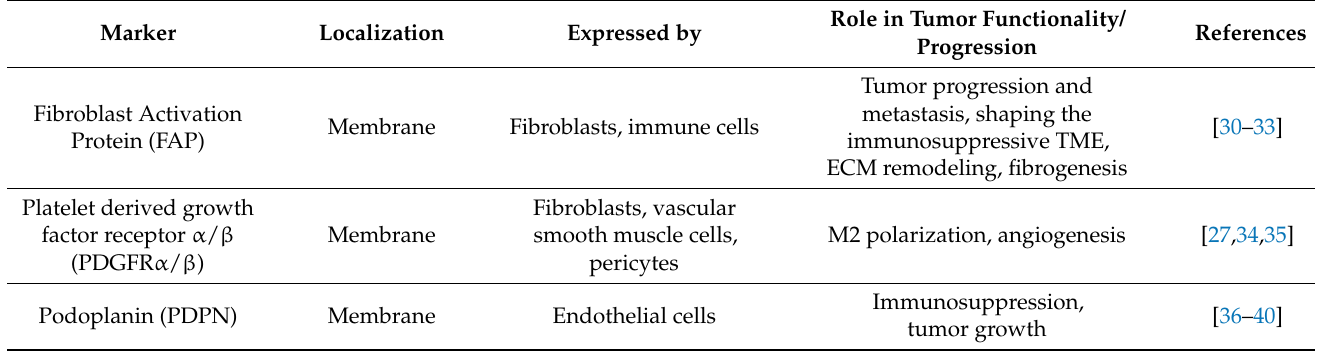
Table 1. Biomarkers used to identify fibroblasts and cancer-associated